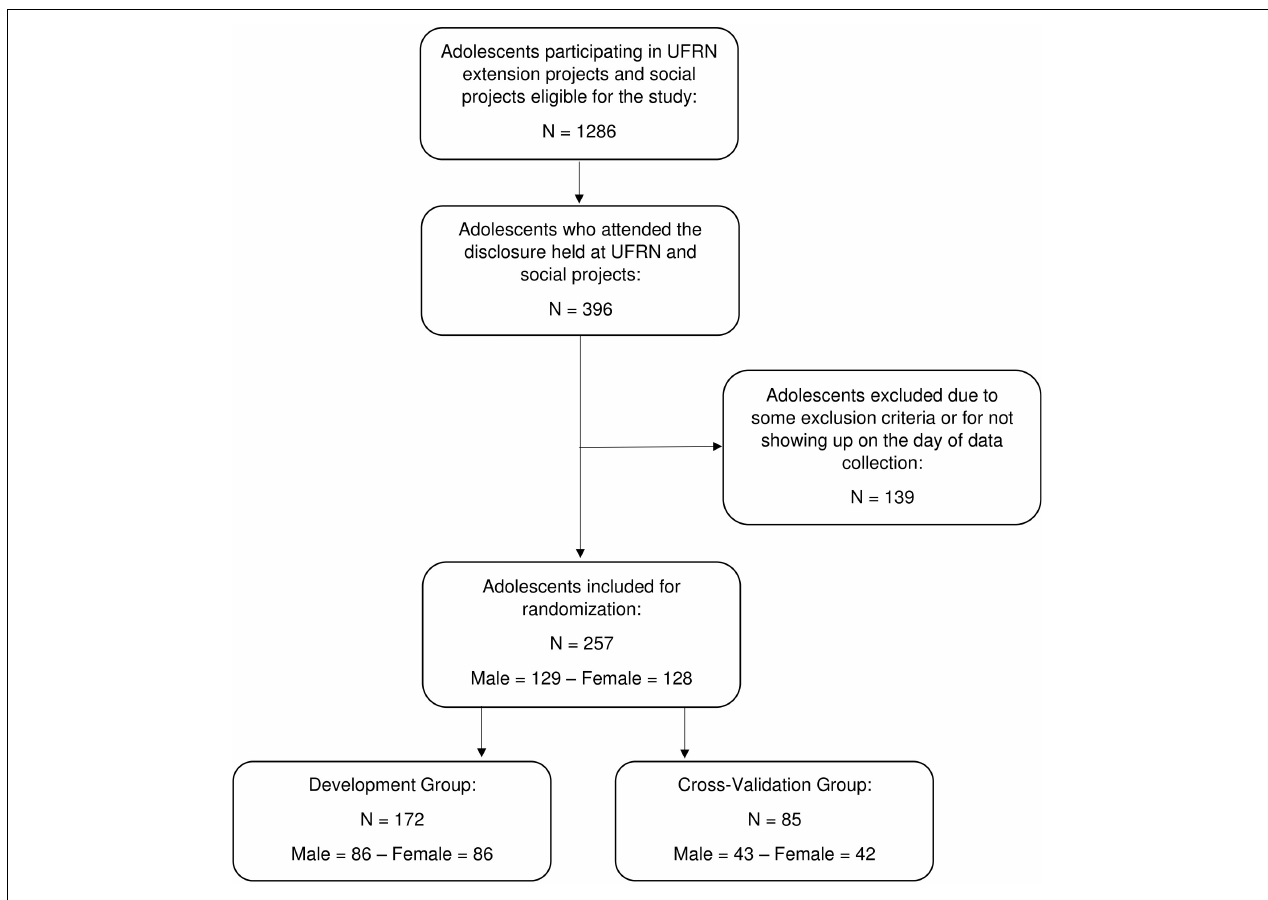
FIGURE 1 | Flowchart of the study